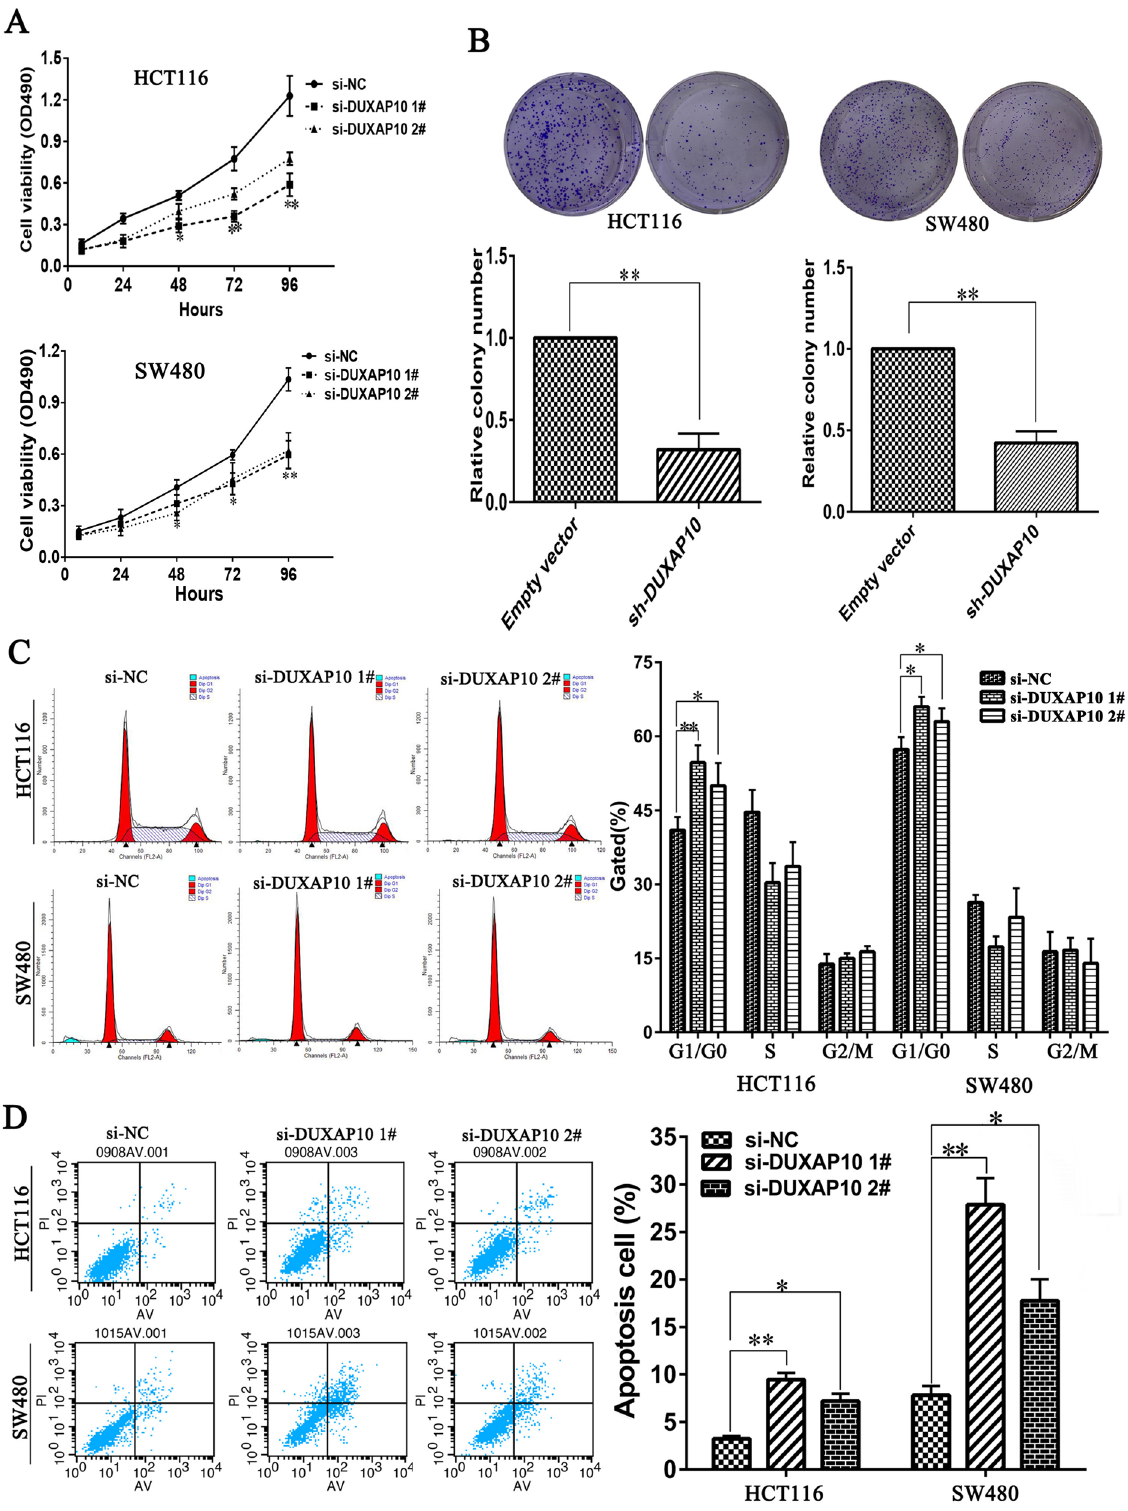
Figure 3. Effects of DUXAP10 on CRC proliferation and apoptosis in vitro . ( A ) MTT assays were performed to determine the cell viability of HCT116 and SW480 cells after the transfection of siRNA against DUXAP10. ( B ) Representative results of the colony formation of HCT116 and SW480 cells transfected with the siRNA of DUXAP10. ( C ) Flow cytometry assays were performed to analysis the cell cycle progression when HCT116 and SW480 cells transfected with siRNA against DUXAP10. ( D ) Flow cytometry assays were performed to analysis the cell apoptotic in siRNA-transfected HCT116 and SW480 cells. Representative images and data based on three independent experiments. Bars: s.d, * P < 0.05, ** P <